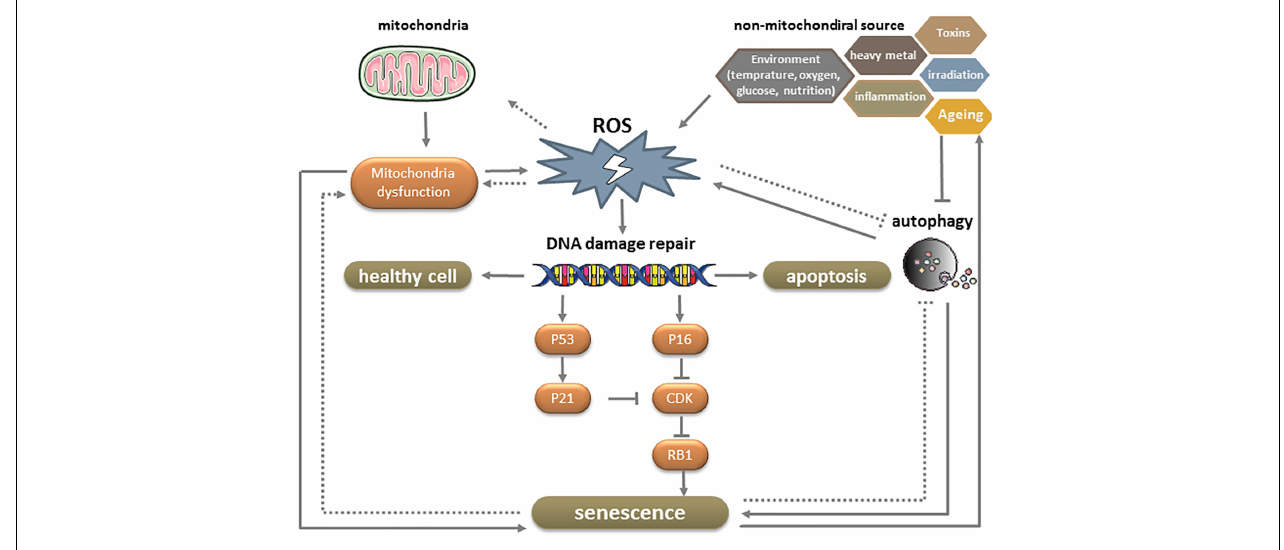
FIGURE 4 | Effect of ROS on MSC